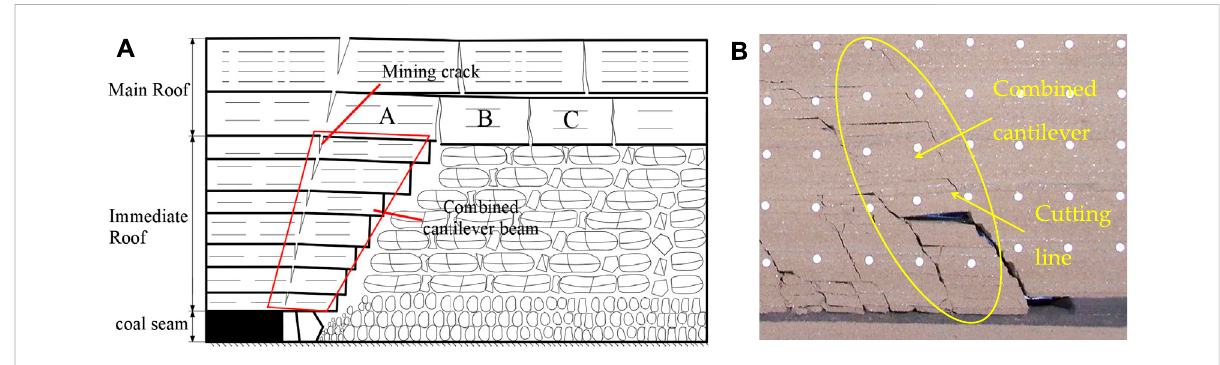
FIGURE 1 The combined cantilever beam structure in a fully-mechanized mining face: (A) roof structural model, (B) physical simulation result of roof